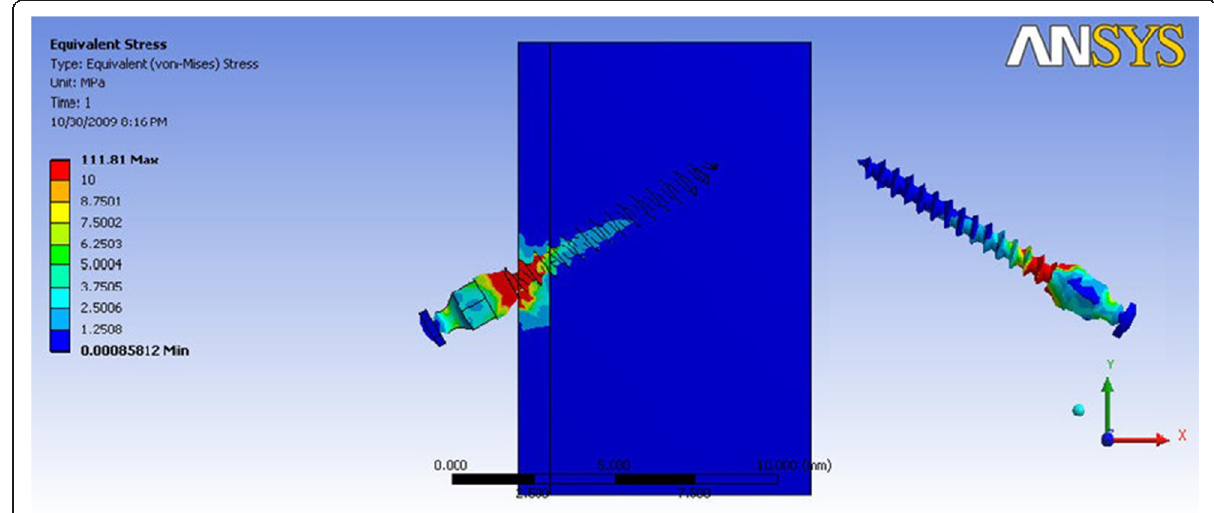
Fig. 8 von Mises stress distribution for mini-implant group 4b — molar intrusion: von Mises stress distribution seen at the bone-implant interface and in the mini-implant alone. Maximum stress seen in the mini-implant was at 111.27